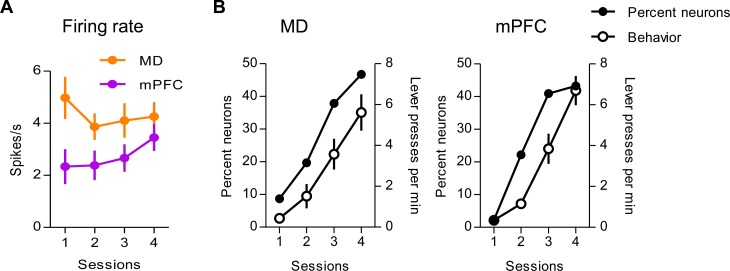
Neural plasticity in MD and mPFC during learning.A, The firing rates of all responsive neurons in the MD (n = 69, 71, 66, 62 for each recording session) and mPFC (n = 44, 45, 44, 37) upon the reward delivery during acquisition. B, Dramatic increase in overall percentage of neurons whose activity is modulated by the reward delivery (both excited and inhibited). The rate of lever pressing across 4 training sessions is also plotted MD and mPFC activity was recorded simultaneously from 5 rats. MD activity only was recorded from 3 rats. Error bars represent SEM.